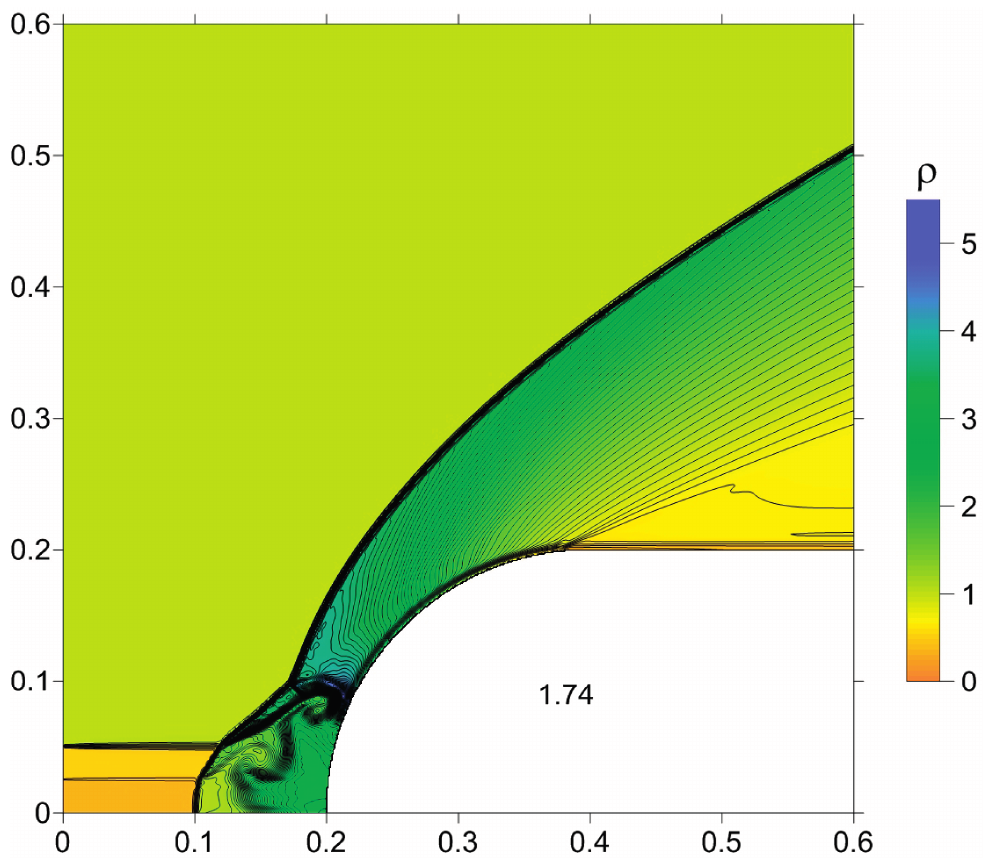
Figure 8. Beginning of the interaction, M = 3.45, α ρ = 0.5, α ρ 1 = 0.35, t = 1.74.